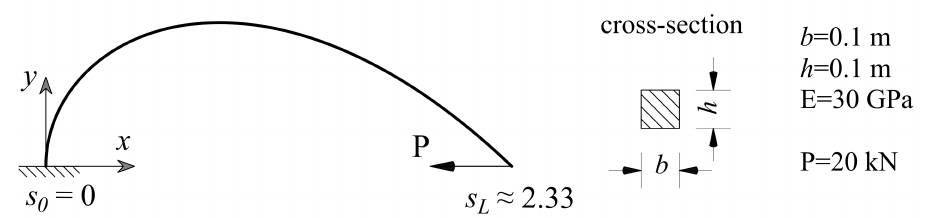
Figure 2. Geometric and material properties, and applied